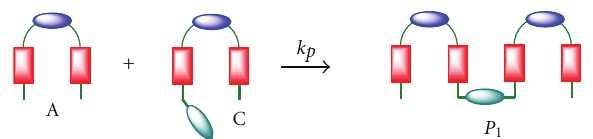
Scheme 6: Reaction scheme for kinetic model 4. Reaction of C with A to give P 1 .